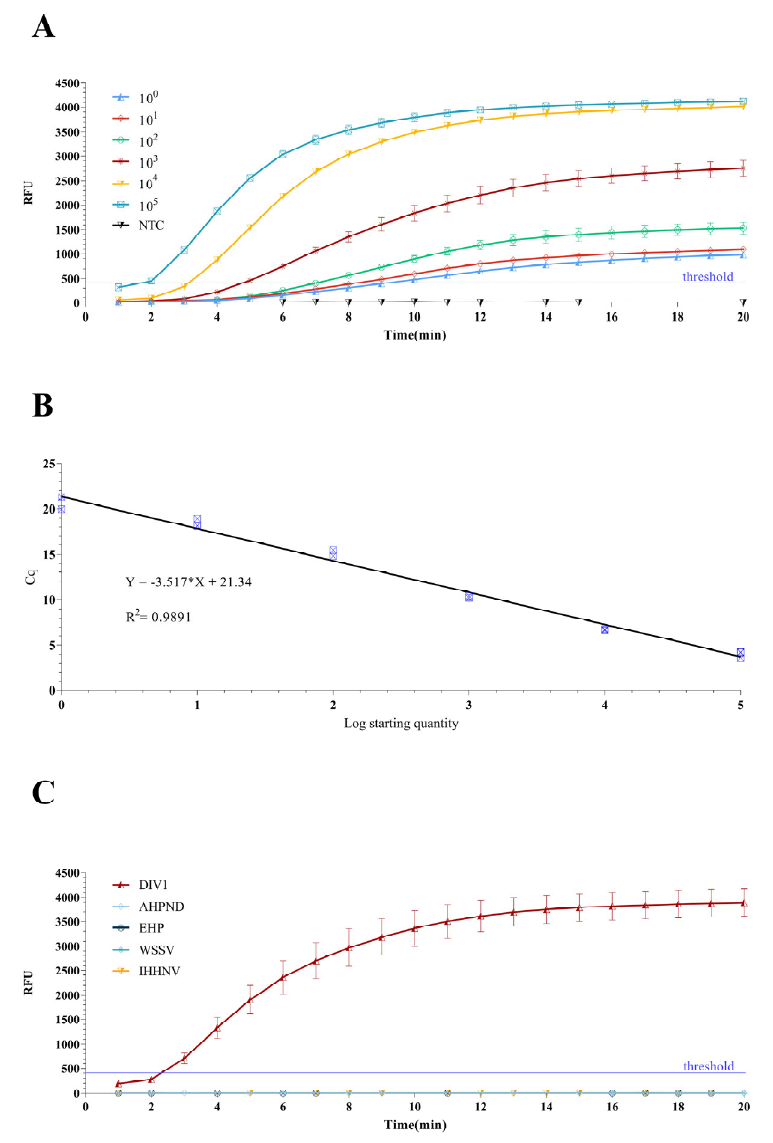
Figure 4. Analytical sensitivity and specificity test of DIV1 ‐ qRPA. ( A ) Amplification curves of DIV1 ‐ qRPA assay using positive plasmid samples in a concentration range of 1.0× 10 5 to 10 1 copies ∙μ L − 1 . NTC, 10 5 , 10 4 , 10 3 , 10 2 , 10 1 , and 10 0 denote the samples at the concentrations of 0, 1.0 × 10 5 , 1.0 × 10 4 , 1.0 × 10 3 , 1.0 × 10 2 , 1.0 × 10 1 , and 1.0 copies ∙μ L − 1 , respectively. ( B ) Standard curve of the DIV1 ‐ qRPA assay. ( C ) Amplification curves of the DIV1, WSSV, IHHNV, Vp AHPND , EHP, and NTC.